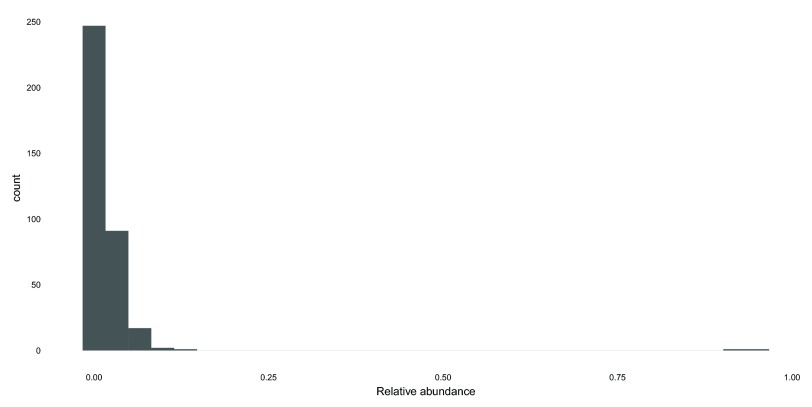
The outlier samples are dominated by a single RSV.